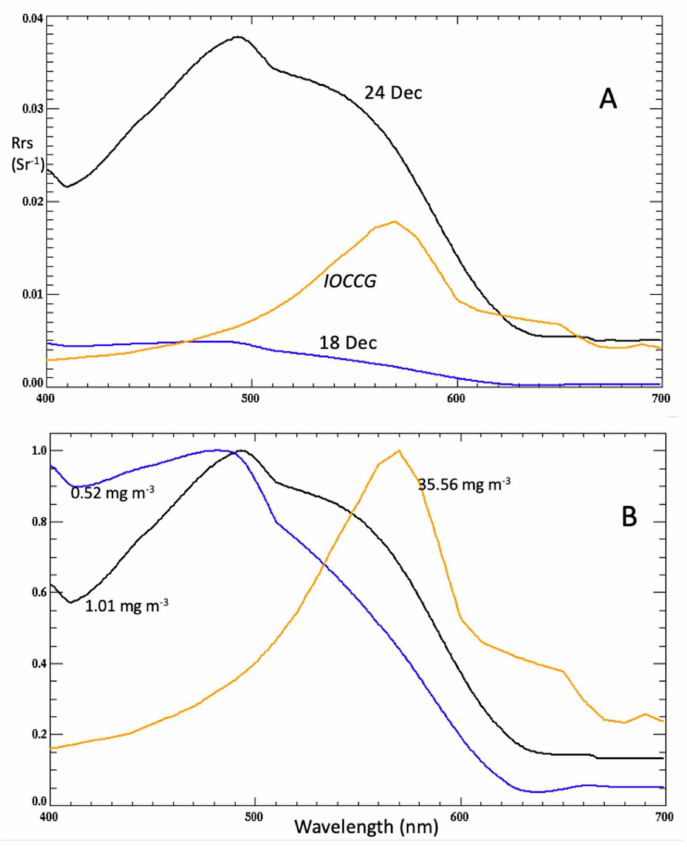
Figure 14. ( A ) Extracted and interpolated hyperspectral Rrs spectra for 18 Dec (OLCI; Sent 3A; blue line), 24 Dec (OLCI; Sent 3B; black line), and IOCCG reference coastal turbidity spectrum (brown line) and ( B ) same as in ( A ) with the spectra normalized by their respective maximum values. The corresponding OCx chlorophyll algorithm value is shown on the